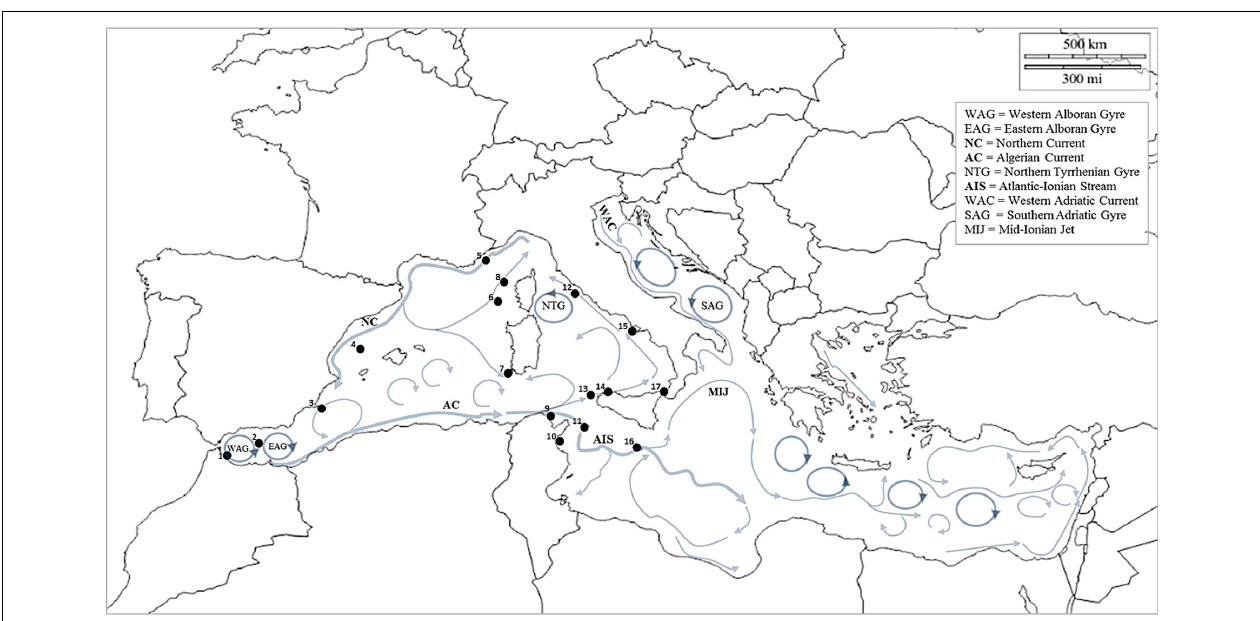
FIGURE 1 | Map of the Physalia physalis records in the Mediterranean Sea (1850 – 2021). The black points with the ID number indicate the area where P. physalis was found. The localities reported in Table 1 are associated with the ID number of such areas according to a neighbouring criterion. The arrows indicate the model of the main surface currents present in the Mediterranean Sea, according to Millot (1999) and Poulain et al.